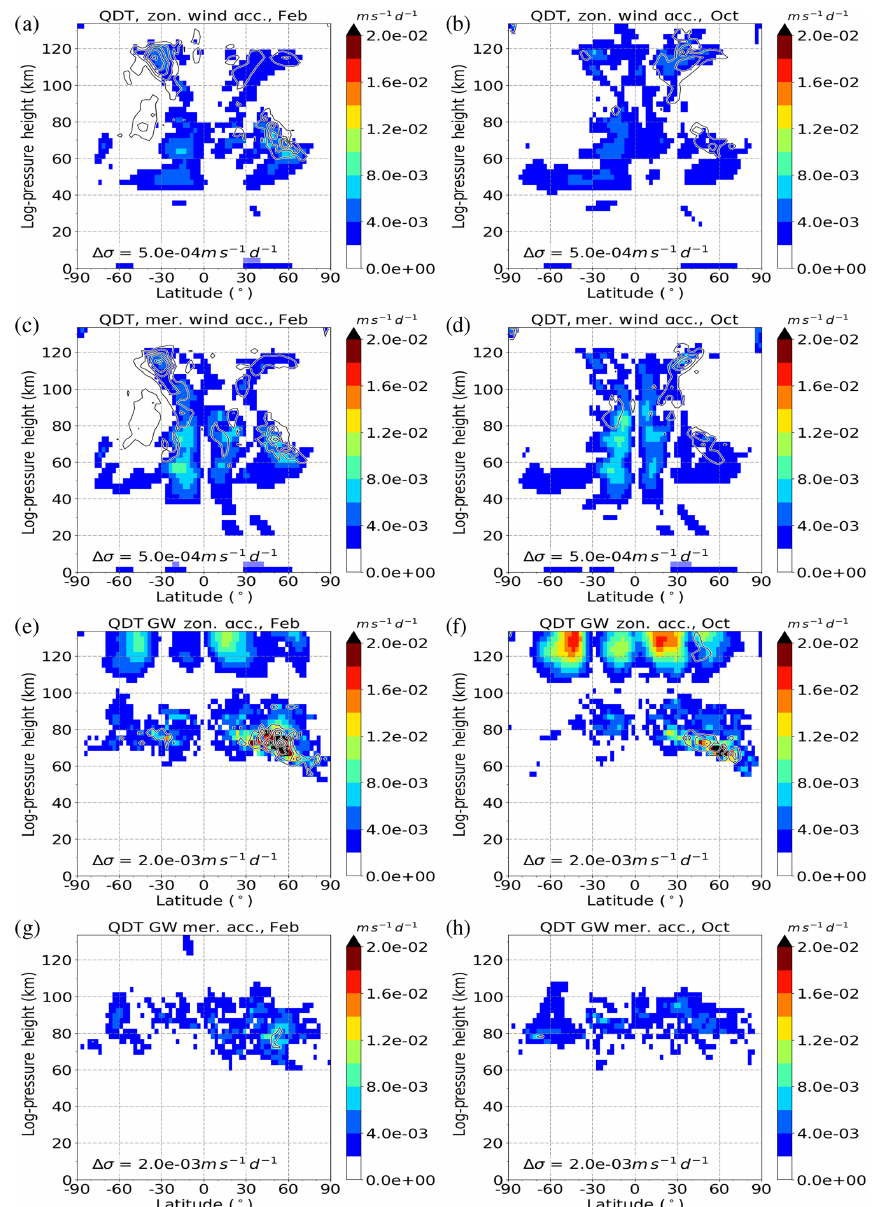
Figure 4. Quarterdiurnal component of zonal and meridional wind acceleration terms in the REF simulation for February conditions (a, c, e, g) and October conditions (b, d, f, h) . Amplitudes are scaled by exp [− z( 2 H) − 1 ] . Results are an average of the 11 ensemble members (shaded color). Standard deviations ( σ ) are added as gray contour lines. Panels (a) and (b) show the zonal wind advection (nonlinear component), panels (c) and (d) show the meridional wind advection (nonlinear component), panels (e) and (f) show the zonal acceleration due to gravity waves, and panels (h) and (h) show the meridional acceleration due to gravity waves (tendency terms from gravity wave parameterization). Note that the color scales are